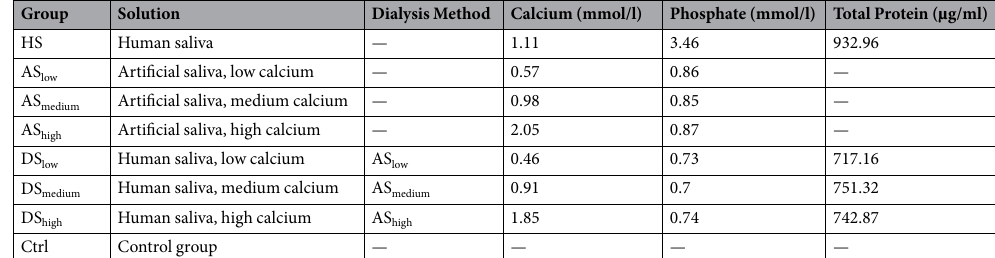
Table 1. Calcium, phosphate and total protein concentrations in each incubation solution according to the different experimental